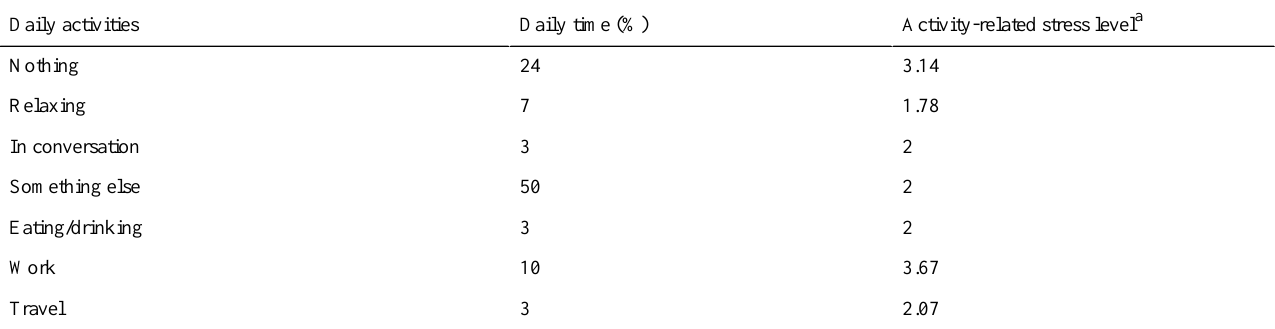
Table 4. Person 1: daily activities and levels of activity-related stress.